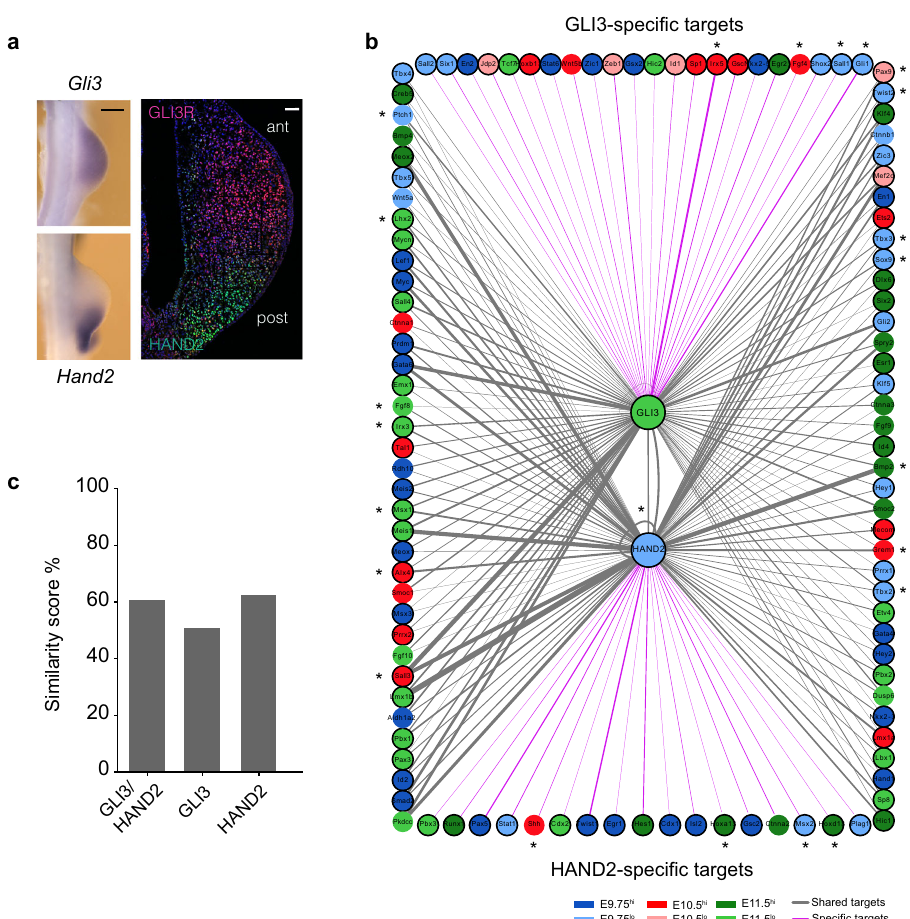
Fig. 6 In silico identi fi cation of candidate GLI3 and HAND2 target genes in mouse forelimb buds. a Left Panel: whole-mount RNA in situ hybridization showing the spatial distribution of Gli3 ( n = 3, upper-left panel) and Hand2 transcripts ( n = 3, lower-left panel) in mouse forelimb buds at E9.75 (scale bar: 250 μ m). Right panel: colocalization of HAND2 (green) and GLI3R (red) proteins in mouse forelimb buds (histological section at E9.75, reproduced from ref. 17 with permission from Developmental Cell ). Scale bar: 50 μ m. b Computational identi fi cation of cis -regulatory interactions of GLI3 and HAND2 with candidate target genes in limb buds. Circles represent nodes while the interactions are represented by solid lines (edges). GLI3 and HAND2 are source nodes (shown in the center) and their candidate target genes are genes linked to accessible regions with GLI3 and/or HAND2 TF binding motifs. The edges of the network represent motifs and are weighted (thickness of the line) based on the number of TF binding motifs within the accessible regions linked to the target gene, which support a connection. GLI3 and HAND2-speci fi c interactions are shown by magenta-colored lines while shared interactions are represented by gray lines. The color code of the candidate target genes corresponds to their closest DEG module based on the correlation of their gene expression with cluster centroids. Target genes encoding transcriptional regulators are outlined in bold. Molecularly and/or genetically veri fi ed GLI3 and HAND2 target genes are indicated by asterisks. c Bar plot showing the similarity score as a percentage of the GLI3 and HAND2 mediated interactions shared between developing mouse forelimb and chicken wing buds (see also Supplementary Fig. 8). DEG differentially expressed genes. Source data are provided as a Source Data fi